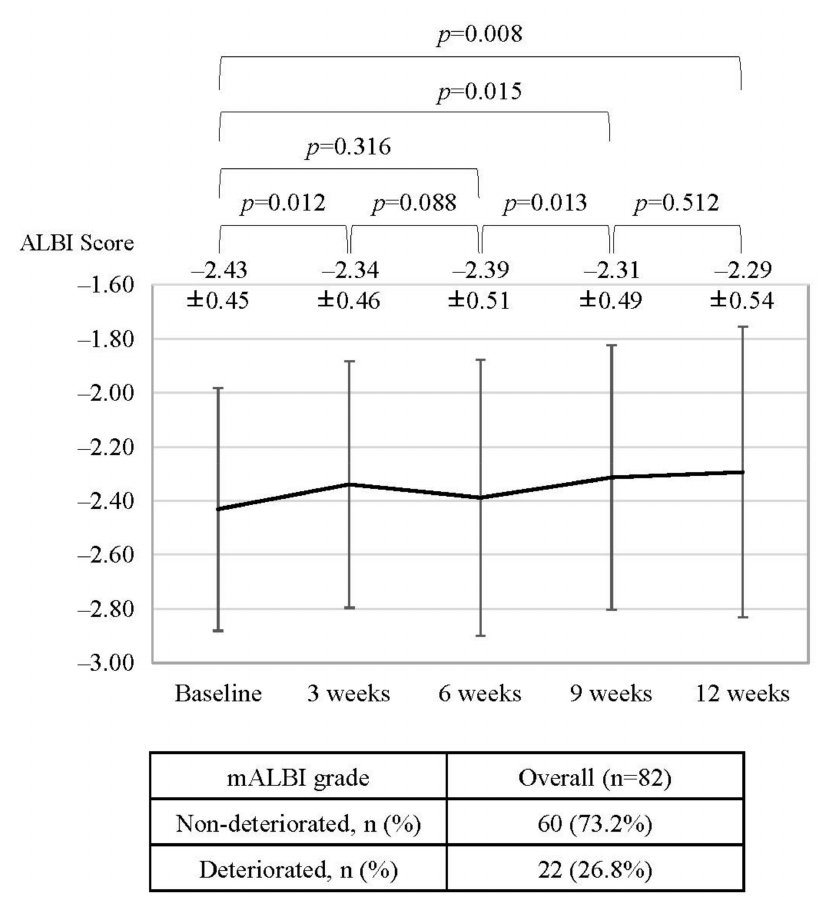
Figure 3. Changes in the ALBI score and mALBI grade during atezolizumab and bevacizumab treatment for unresectable HCC in all cohorts. mALBI: modified albumin-bilirubin grade.